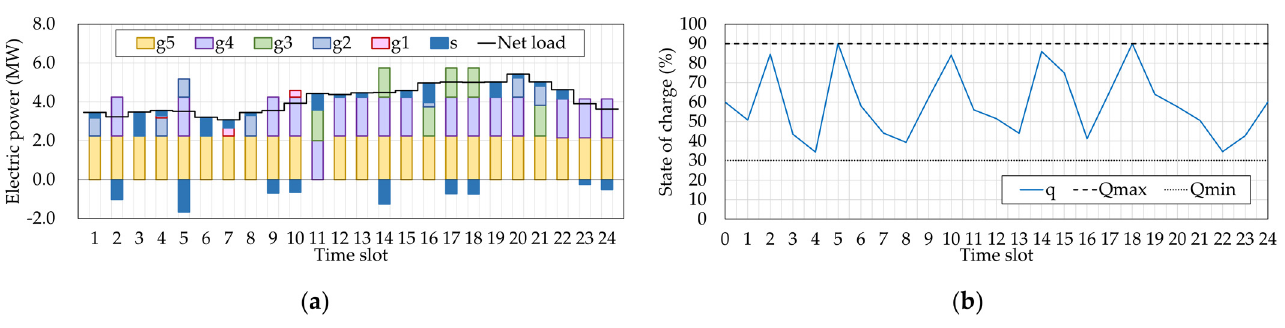
Figure 6. Obtained solution of Case 3 ( Q = 3.00 (MWh)): ( a ) operation schedule; ( b ) transition of SOC level.